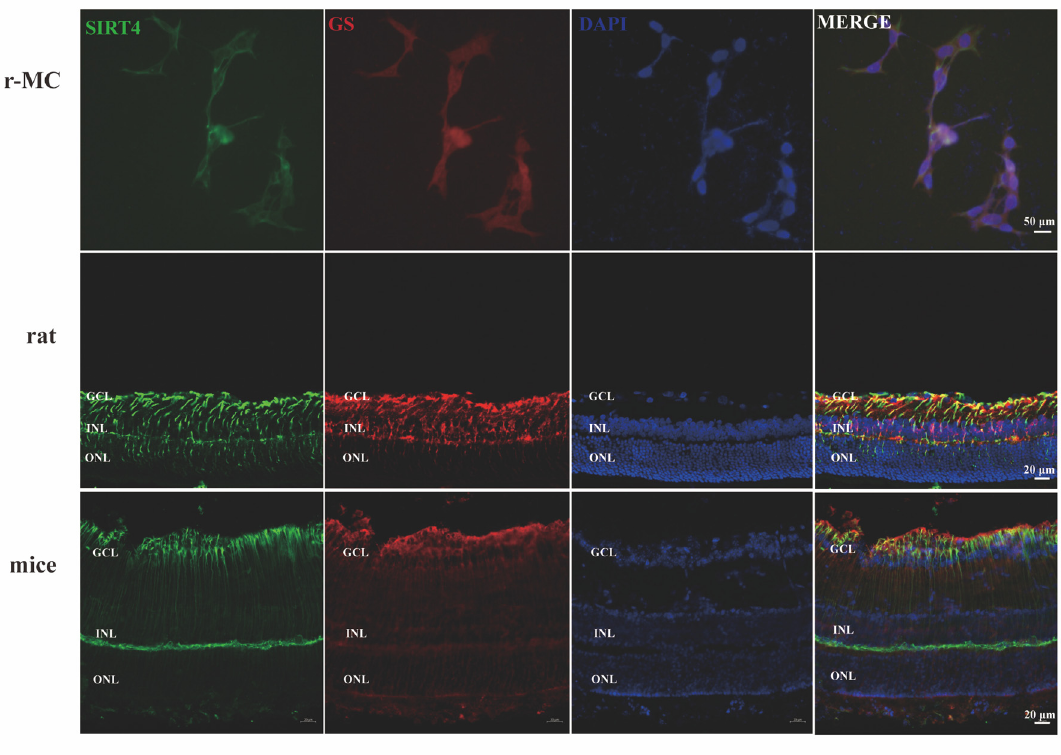
Figure 5. SIRT4 is highly expressed on MGCs. SIRT4 and GS co-immunostaining was performed on the r-MC cell line (scale bar: 50 µ m), rat retina (scale bar: 20 µ m), and mouse retina (scale bar: 20 µ m). GS, glutamine synthetase; GCL, ganglion cell layer; INL, inner nuclear layer; ONL, outer nuclear